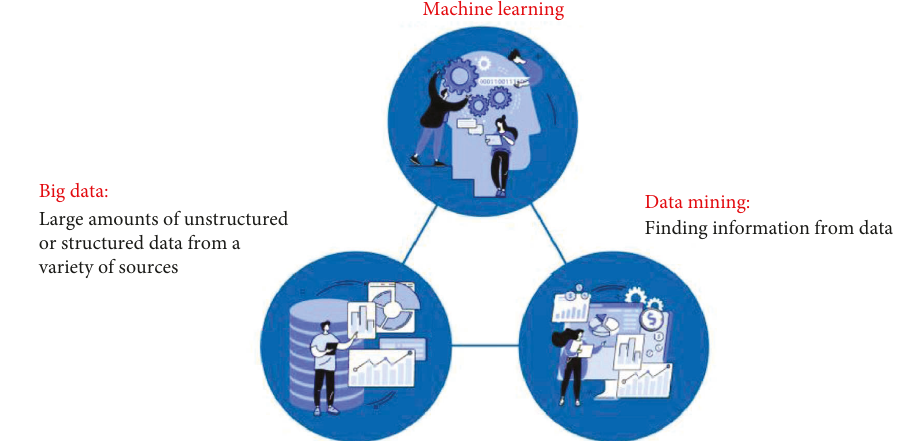
Figure 1: Compressed domain